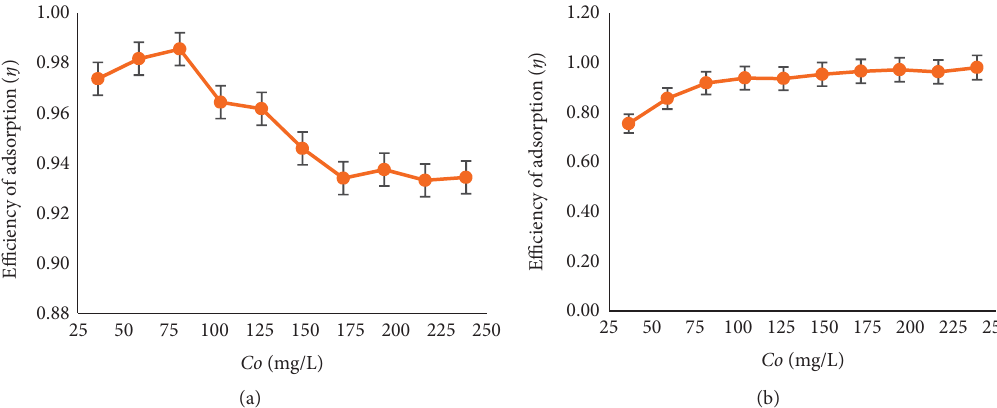
Figure 7: Nance peels: effect of initial concentration ( C 0 ) of MB on the efficiency of adsorption at pH 7 (a) and pH 10 (b).